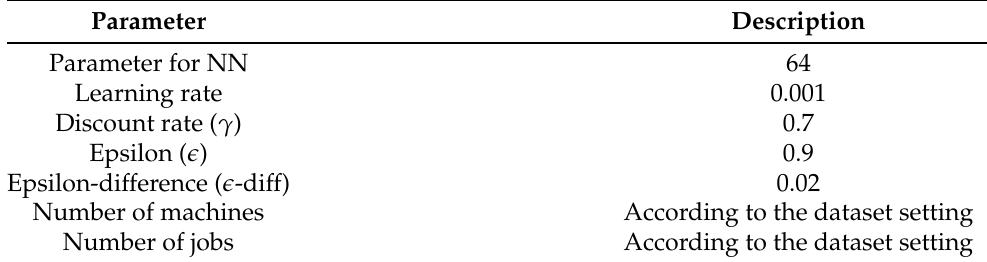
Table 1. Description of the